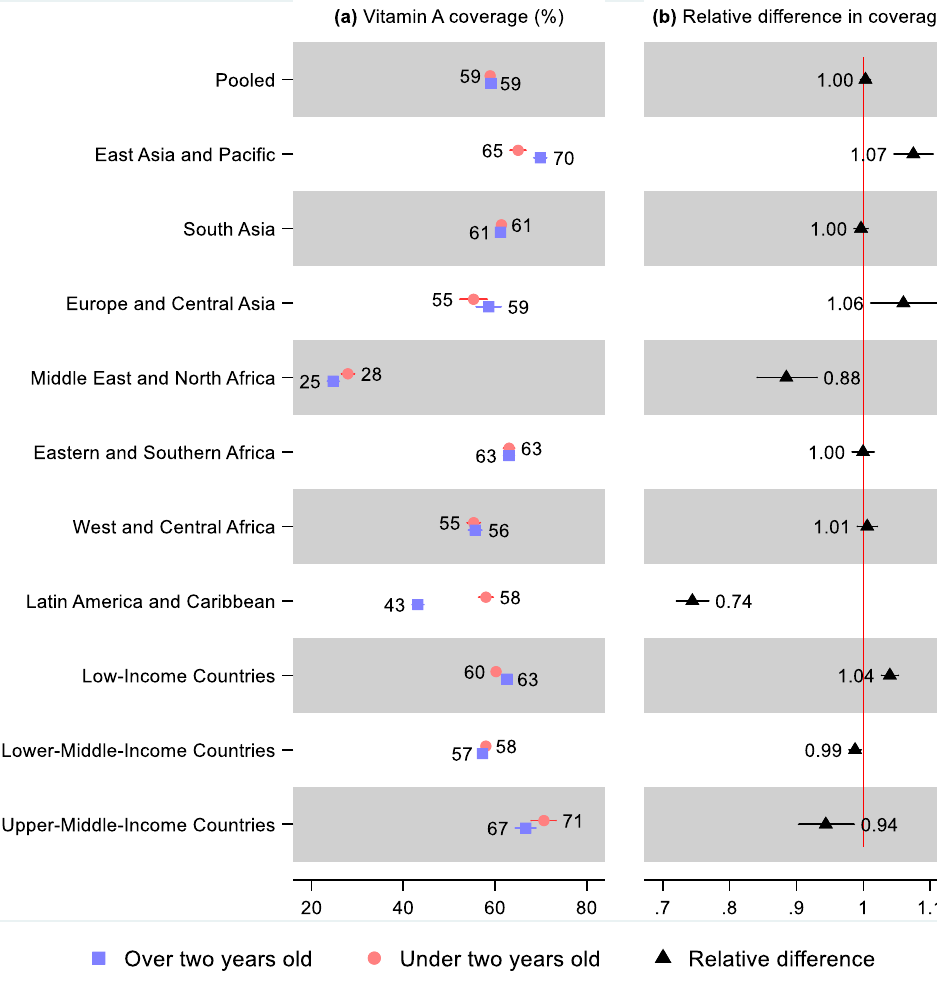
Figure 9. Percentage of children under two years old (6–23 months old) and over two years old (24–59 months old) that received vitamin A supplementation in low- and middle-income countries. Notes: 95% confidence intervals are shown. Some confidence intervals may be narrower than the symbol for the estimate and are therefore not visible. See Table S17 in the Supplement for the tabulated estimates and confidence intervals. See Tables S18–S20 and Figures S25–S27 in the Supplement for the differences by sex, living standards, and urban–rural residency.